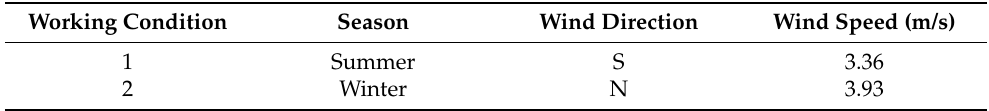
Table A1. Daily Wind Environment